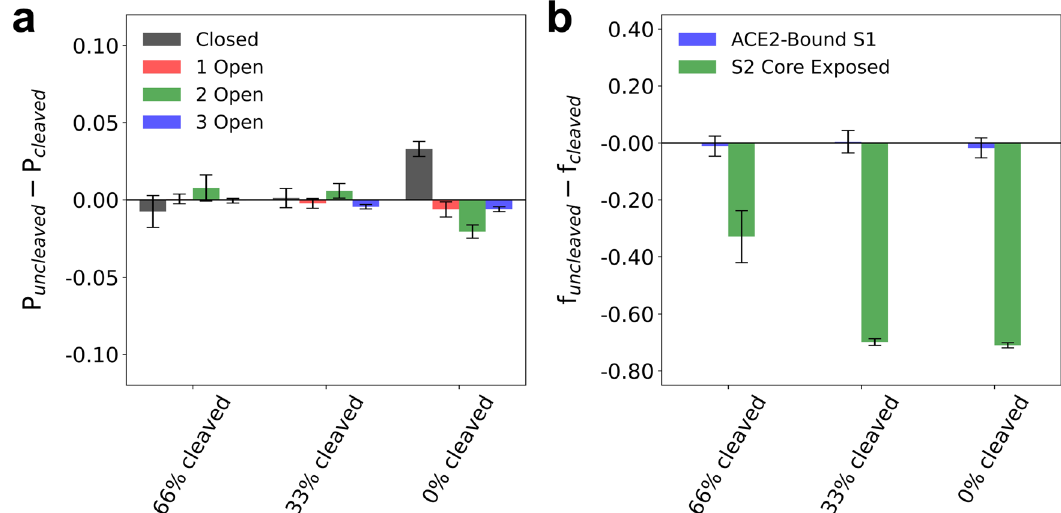
Fig. 6 Comparison between spike trimer S1/S2 cleavage states for the wild type (WT) CG model. a Summary statistics for the difference in the probabilities of the closed (black), 1 RBD open (red), 2 RBD open (green), and 3 RBD open (blue) conformational states for the partially cleaved and completely cleaved spike trimer states ( P uncleaved − P cleaved ) for WT virus. b Summary statistics for the difference in the fraction of S1 monomers bound to ACE2 (blue) and spike trimers with complete exposure of the S2 trimeric core (green) for the partially cleaved and completely cleaved spike trimer states ( f uncleaved − f cleaved ) for WT virus; here, the stoichiometric ratio of ACE2 dimers to spike trimers is 2.56:1 (i.e., 64 ACE2 dimers to 25 spike trimers). In each simulation, the cleavage states are homogeneously distributed, e.g., the 66% cleaved system consists of 2 out of 3 cleaved protomers in every spike trimer. All data points report the mean and standard error from triplicate